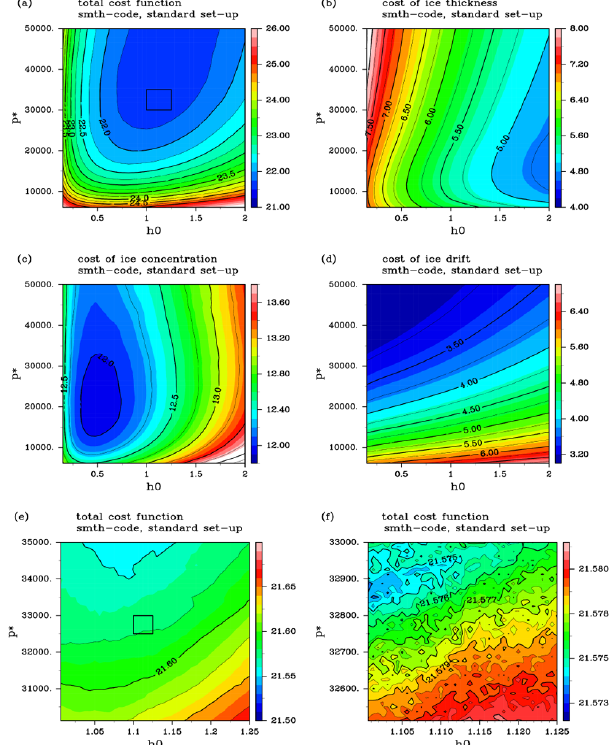
Fig. 6. A two-dimensional structure of the total cost function in